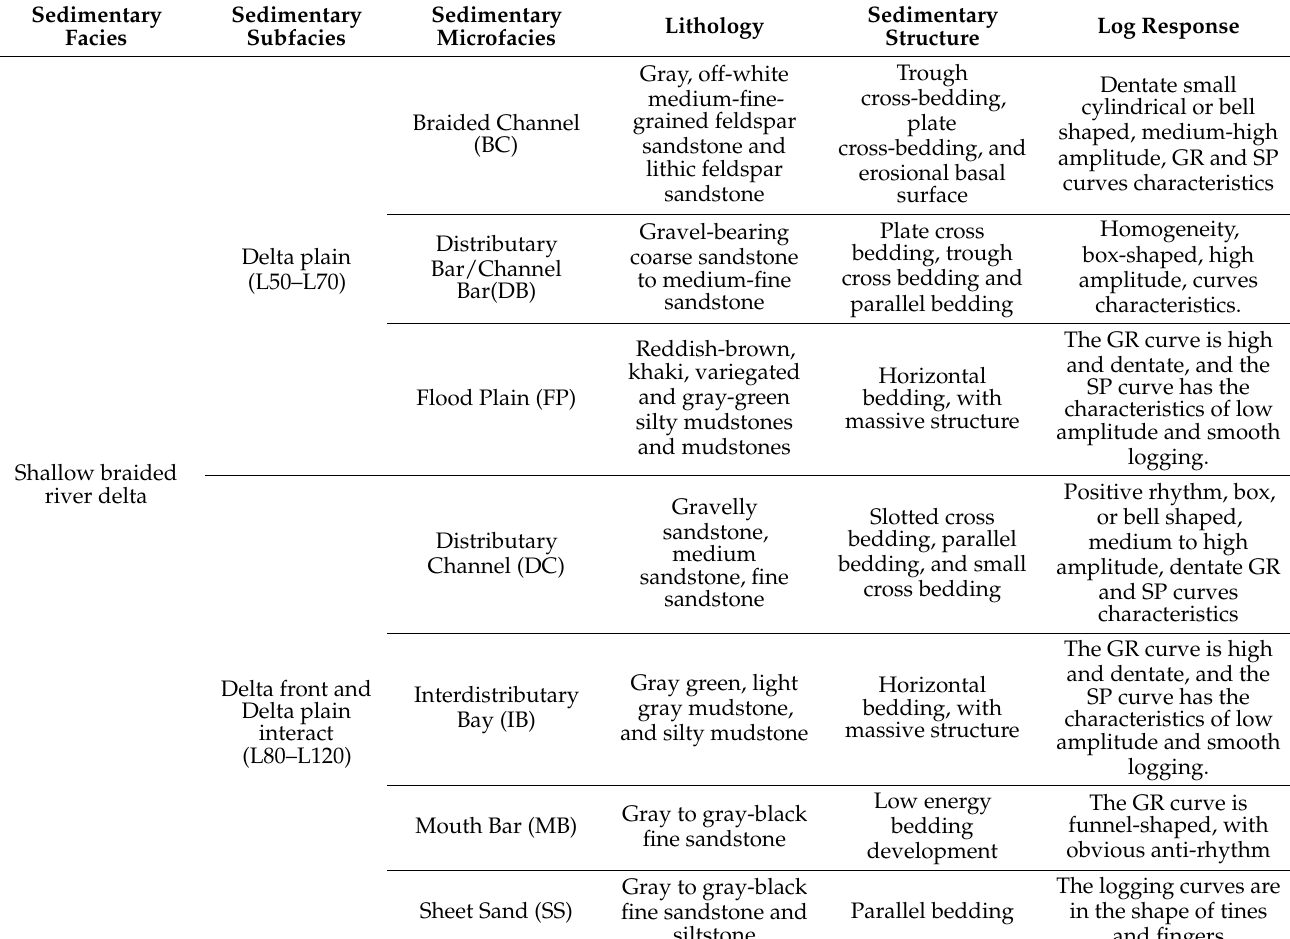
Table 1. Sedimentary characteristics and logging